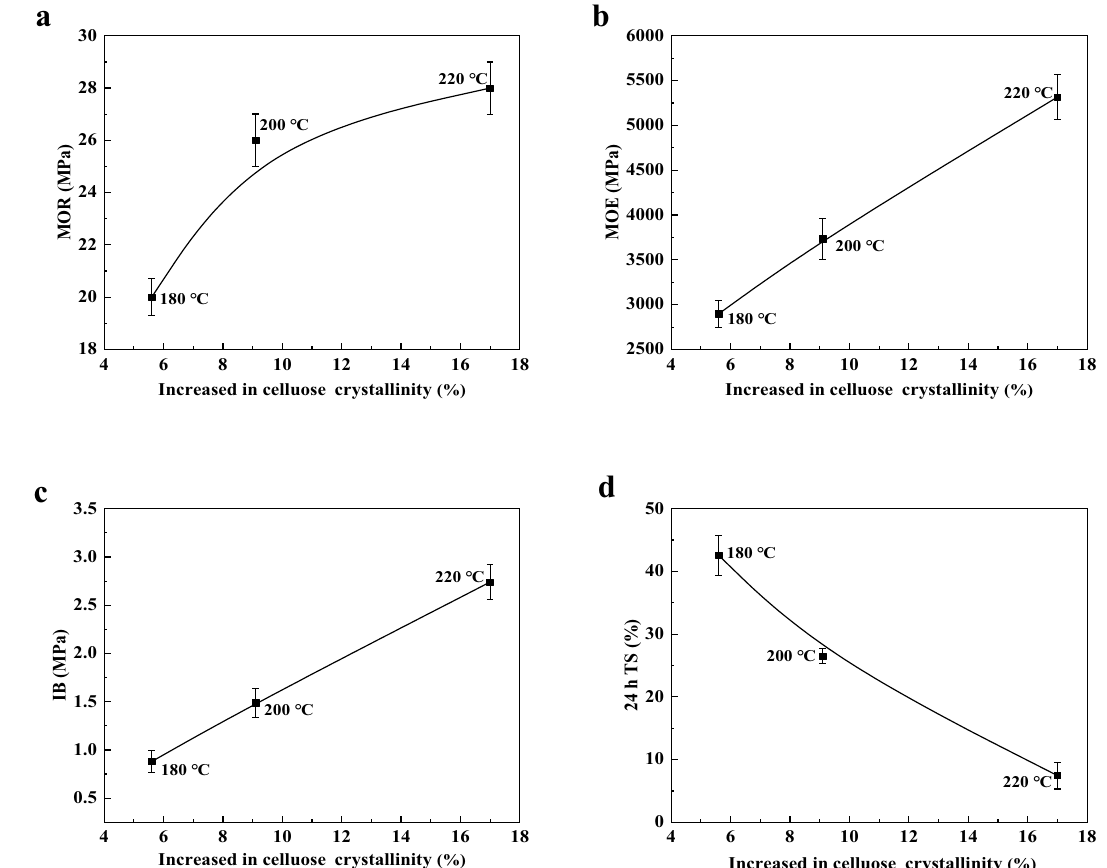
Fig. 11 Correlation between the change in the cellulose crystallinity and properties of binderless board. a Effect of an increase in the cellulose crystallinity on MOR of binderless board. b Effect of an increase in the cellulose crystallinity on MOE of binderless board. c Effect of an increase in the cellulose crystallinity on IB strength of binderless board. d Effect of an increase in the cellulose crystallinity on 24 h TS of binderless board. Error bars indicate standard deviations